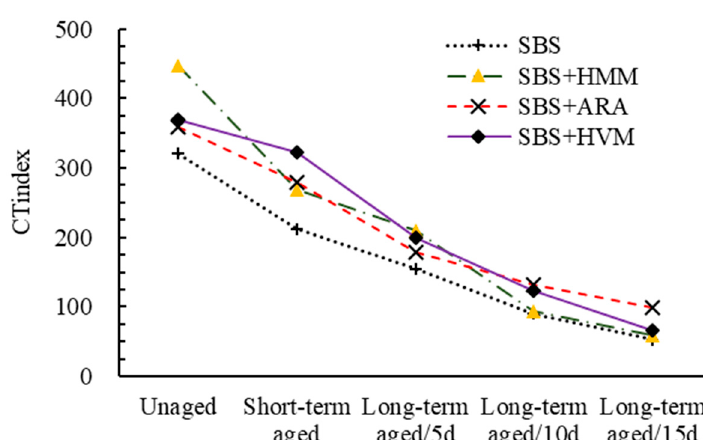
Figure 9. Result of IDEAL cracking tests.